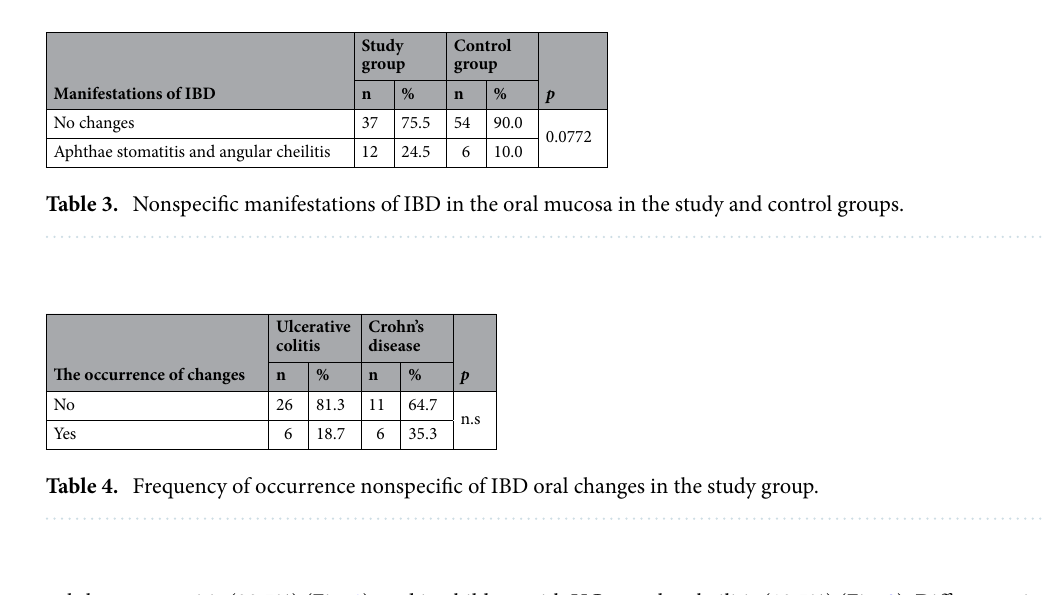
Table 2. Periodontal status in the study and control groups.